Question: Summarize what this figure shows in one sentence.
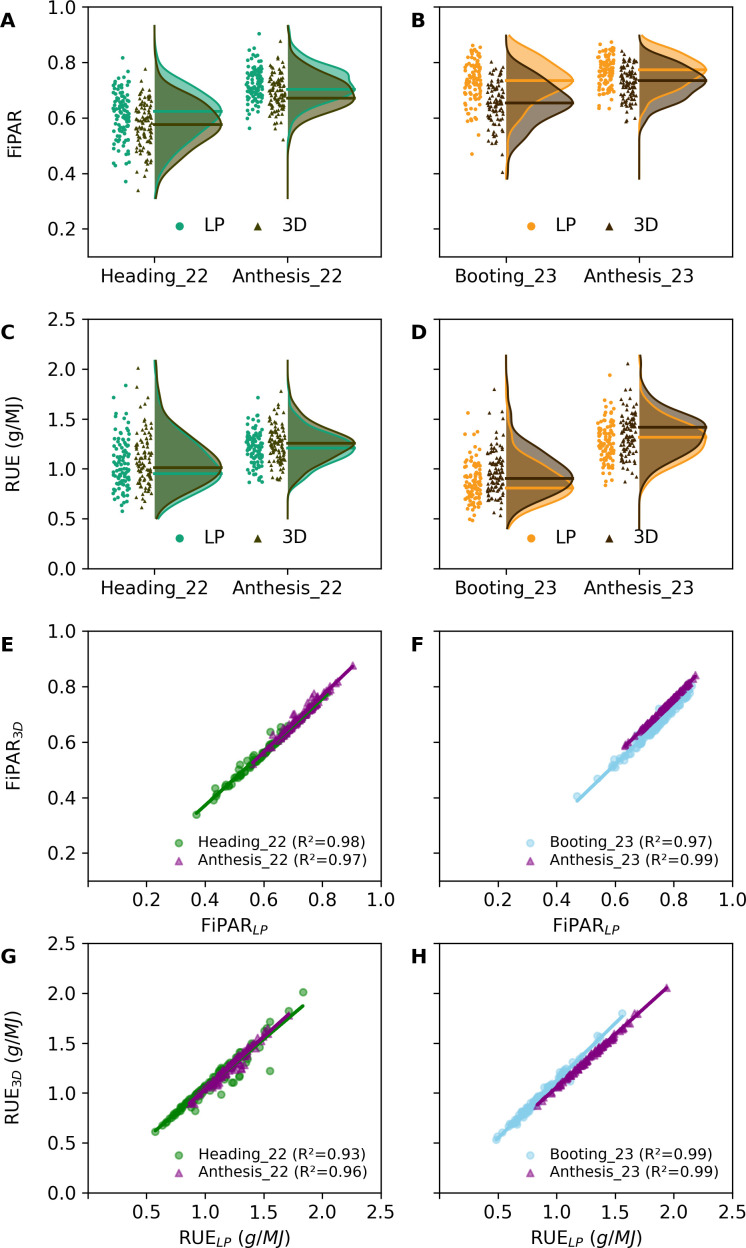
Answer: Distribution and comparison of FiPAR and RUE derived from 3D canopy models and LP80 (manual) measurements at heading and anthesis in 2022 (A, C) , and booting and anthesis) in 2023 (B, D) . (E, F) show the correlation coefficients between FiPAR 3D and FiPAR LP while (G, H) are between RUE 3D and RUE LP at two distinct crop growth stages in 2022 and 2023, respectively.